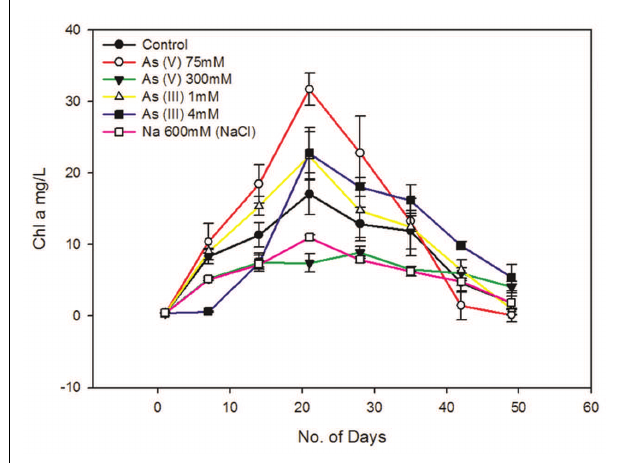
FIGURE 1 | Effect of arsenic and sodium ions (Na + ) on Synechocystis cell growth. 300 mM As (V) and 4 Mm As (III) causes around 40–50% of cell growth inhibition. 300 mM sodium arsenate (Na 2 HAsO 4 .7H 2 O) contains 600 mM of Na + . To study the effect of these Na + on cell growth, cells were cultured with 600 mM NaCl and its effect on cell growth was studied along with As (V) treated and control cells. 300 mM sodium arsenate and 600 mM NaCl treated cells showed quite similar growth pattern, suggesting significant influence of Na + on cell growth in arsenic treated cultures. Distinct increase in Chl a amount was observed in As treated Synechocystis cells after 7 days. 75 mM As (V) shows comparatively higher Chl a increase than 1 mM As (III). The data has been presented as mean ± standard deviation ( n =